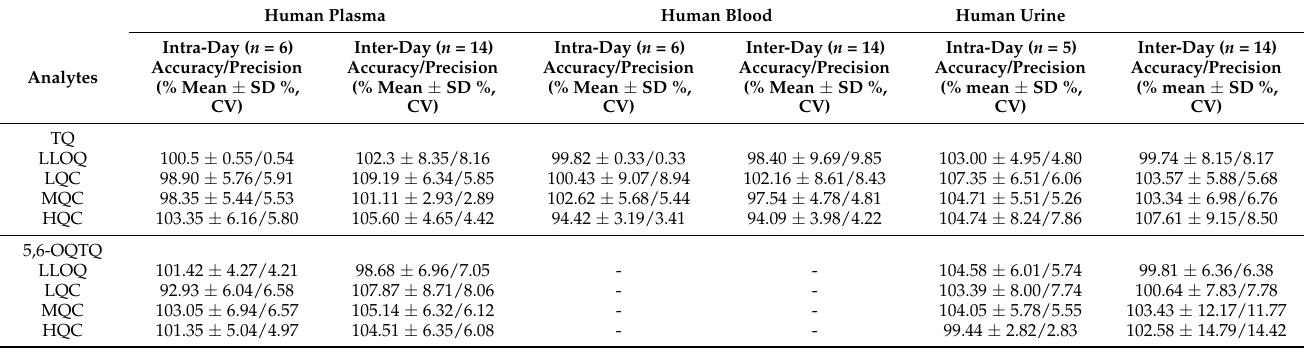
Table 2. Accuracy and precision analysis of TQ and 5,6-OQTQ in human plasma, blood and urine.